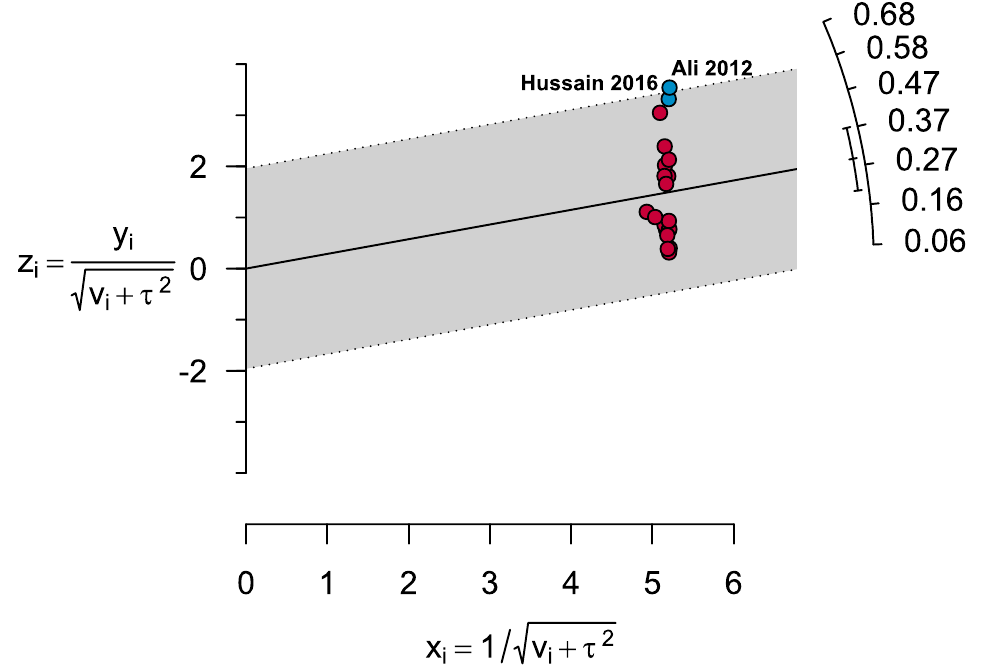
Figure 4. Galbraith plot shows two outlier studies. Table 3. Sensitivity analyses.